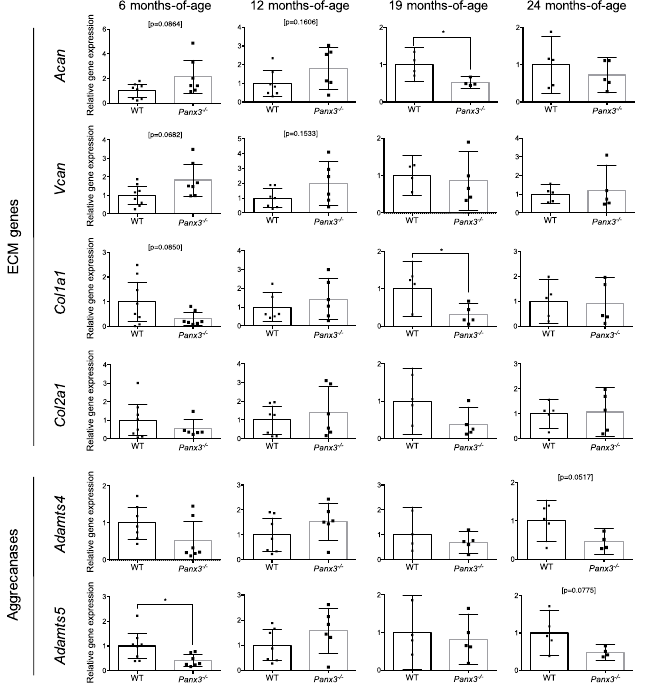
Figure 2. Effect of Panx3 deletion on expression of extracellular matrix (ECM) and aggrecanase genes in the IVD. Analysis of Acan , Vcan , Col1a1 , Col2a1 , Adamts4 and Adamts5 gene expression in thoracic IVDs from 6, 12, 19 or 24-month-old WT and Panx3 -/- mice. Gene expression was determined by relative quantification with values normalized to that of the Rps29 housekeeper and expressed relative to age-matched WT controls. Data are presented as mean ± 95% CI (* indicates p < 0.05, Welch’s t -test; n = 4–8 mice per group, 6–8 IVDs pooled per mouse). Values corresponding to each experimental animal are indicated by individual data points on bar graphs.